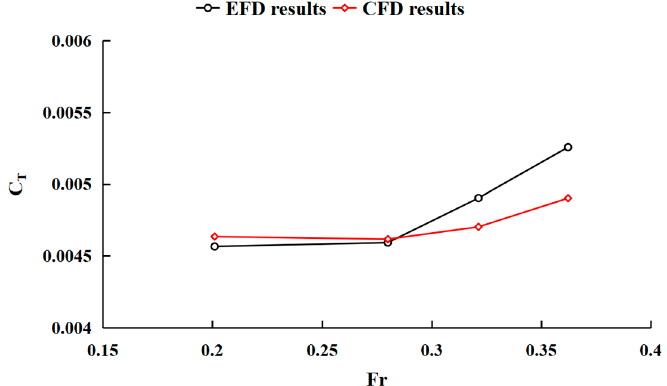
Figure 6. The total resistance coefficient C T for CFD results and experimental value.